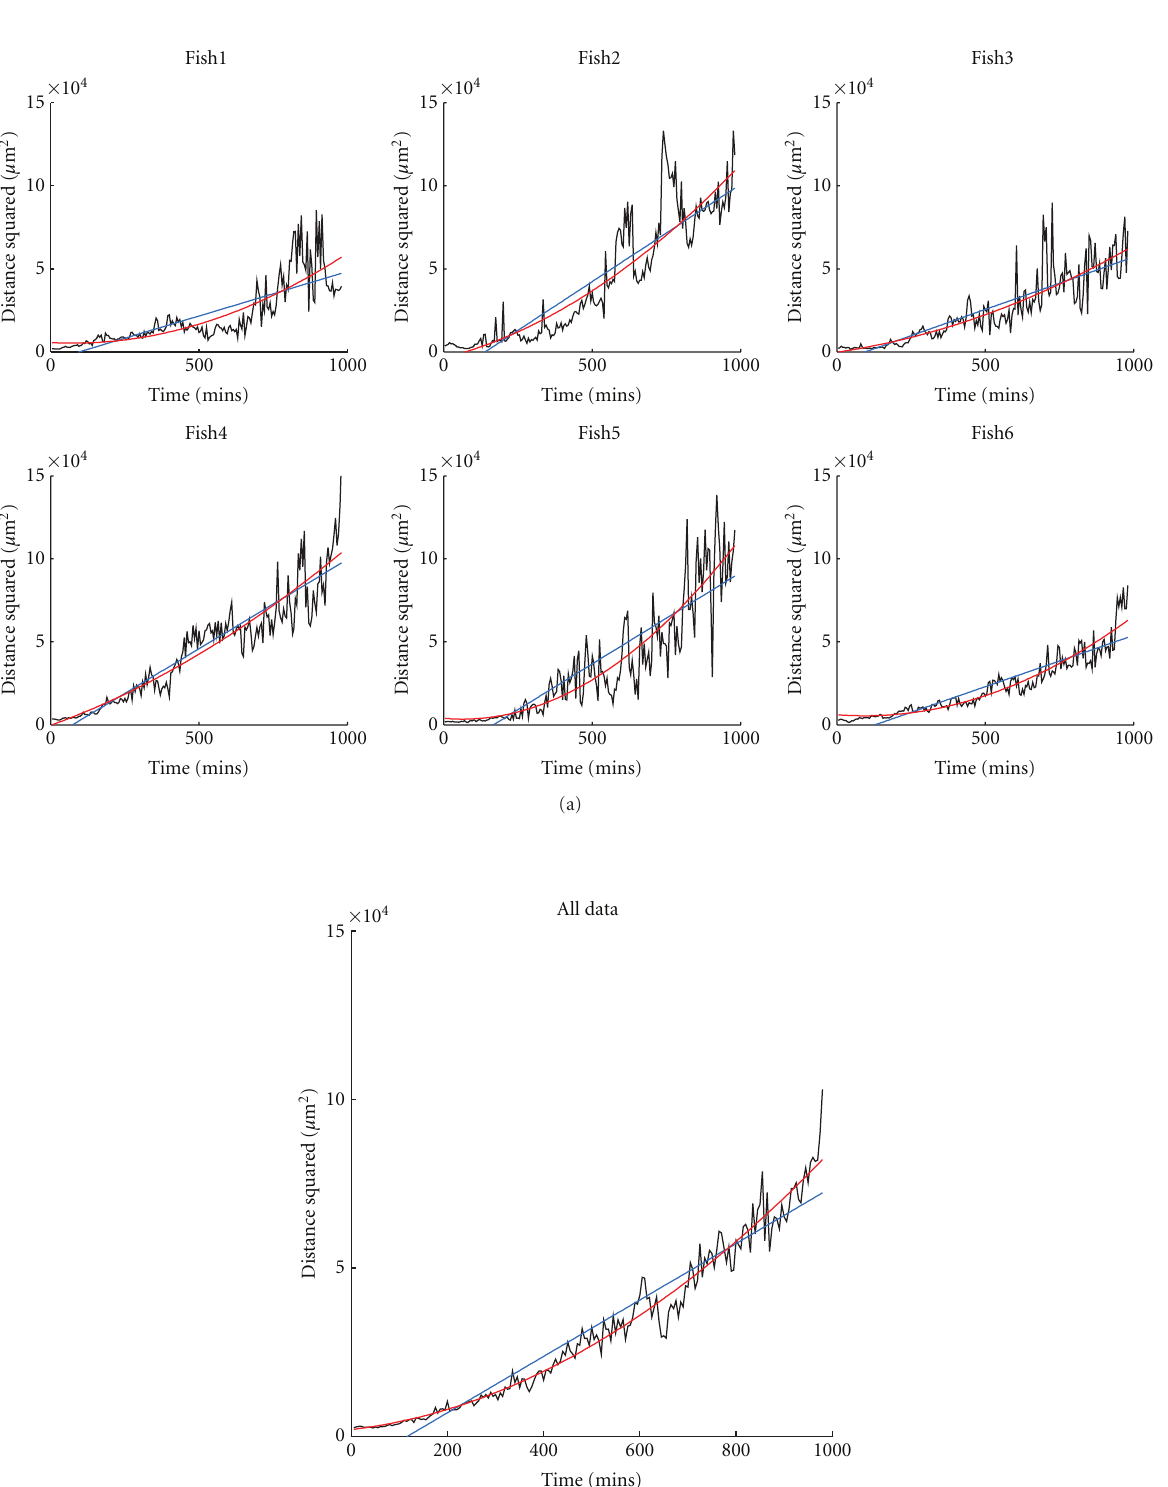
Figure 4: Inflammatory neutrophil behaviour can be fitted by pure-di ff usion and drift-di ff usion models. (a) Plots of mean squared cell distance from the wound against time for the photoconverted (red) neutrophils for datasets 1–6. Also shown on each plot are the fits for the linear model corresponding to pure-di ff usion with zero drift (blue line) and for the drift-di ff usion model (red line). (b) Data and models combined over all